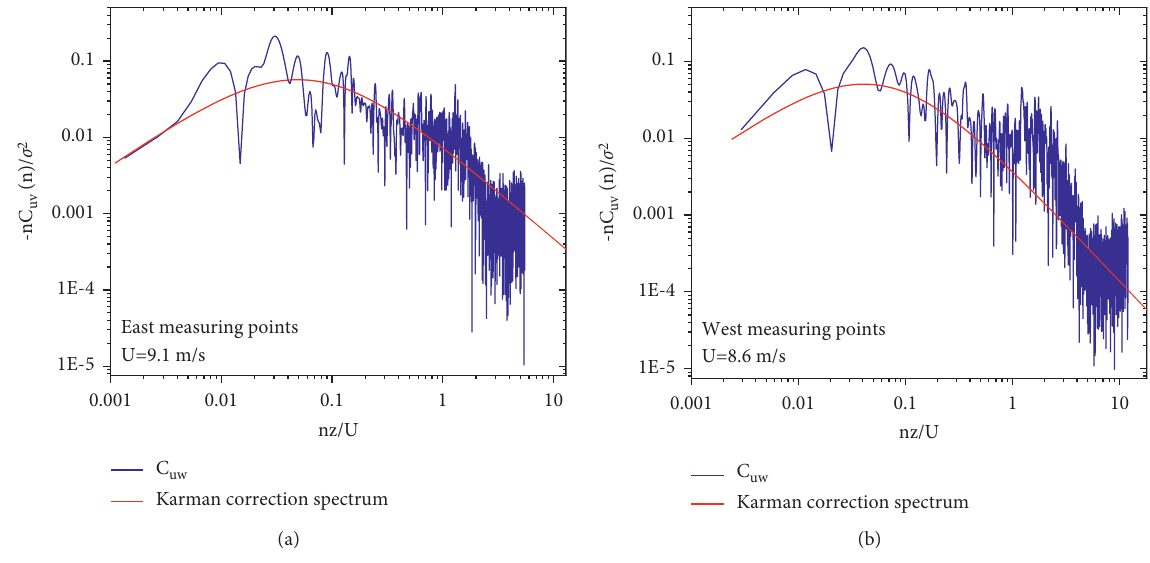
Figure 6: Cross-power spectrum of fluctuating wind speed. (a) Measuring point 1. (b) Measuring point 2.